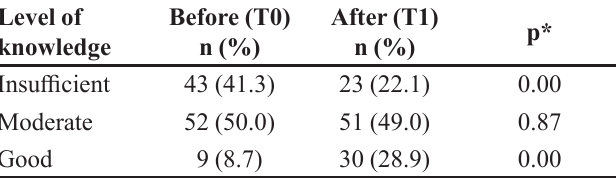
TABLE III – Level of knowledge about medication before (T0) and after (T1) drug dispensation at the University Pharmacy of the Federal University of Goias, 2013 (n=104)